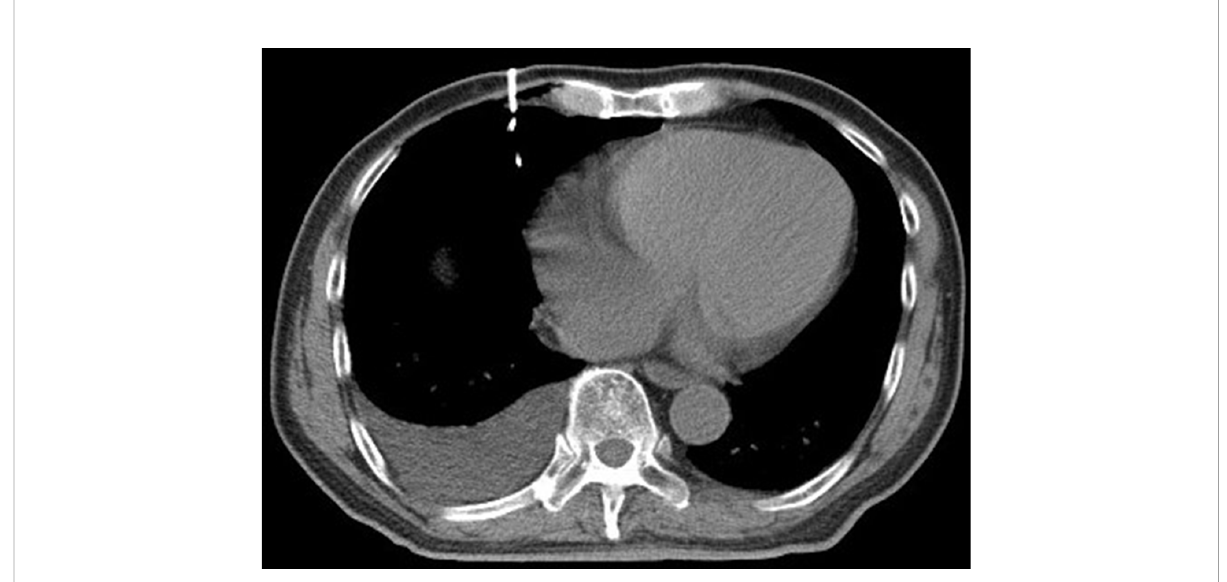
FIGURE 5 To isolate the lesion and the adjacent vital organs, an appropriate amount of normal saline (500 ml) was injected into the catheter to form an isolation belt.